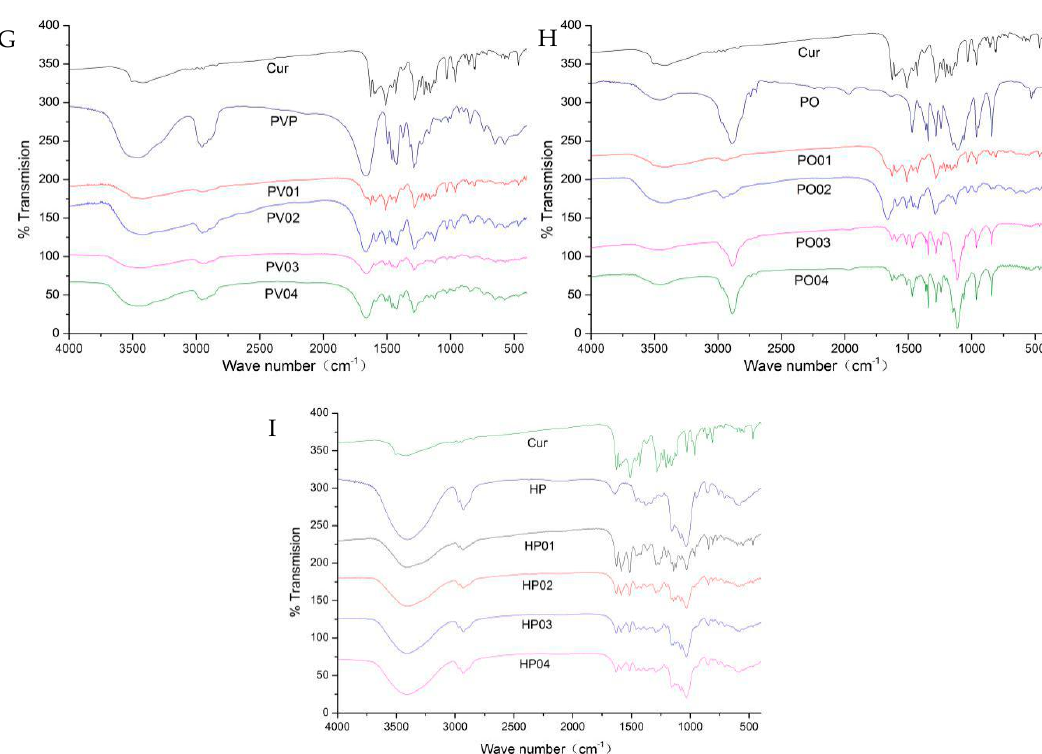
Figure 6. ( A – C ) DSC, ( D – F ) X-ray, and ( G – I ) FTIR spectrum of Curcumin, polymers (various carriers), and Curcumin solid dispersions.